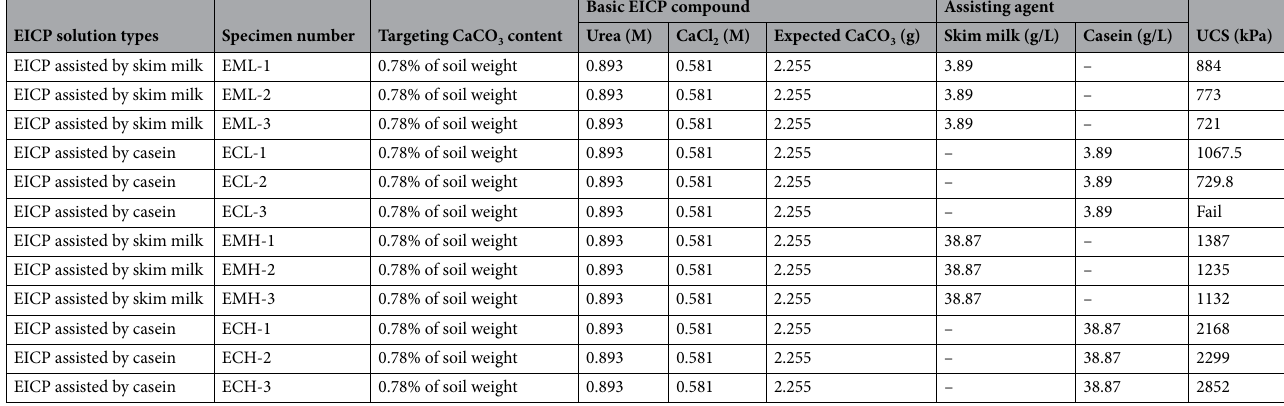
Table 4. Specimen information for EICP treatment and corresponding UCS results for the optimization study of curing and drying strategies. All specimens involves 2.6 g/L of urease enzyme. The skim milk and casein contents were determined as 0.052% and 0.52% of soil weight for low and high concentrations